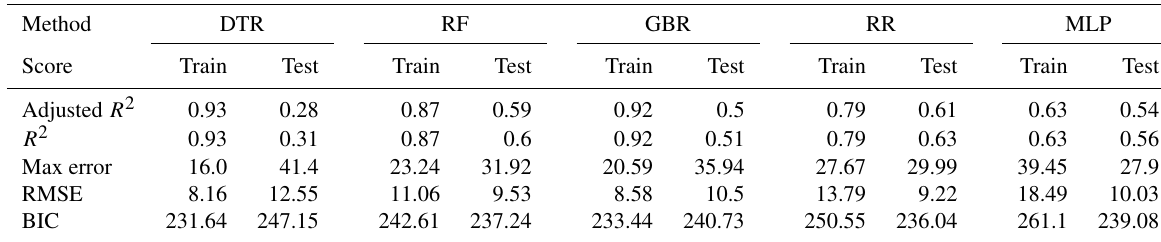
Table A5. Training and test scores on annual basis for the diabetic